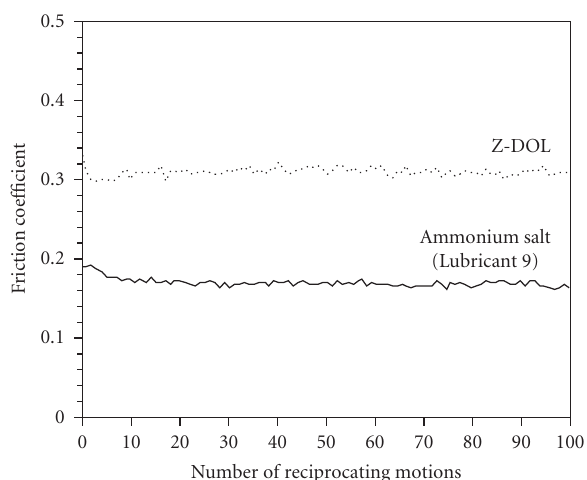
Figure 6: Friction coe ffi cient of the carboxylic acid ammonium salt (Lubricant 9) and Z-DOL during friction test at 25 ◦ C and relative humidity of 60%.